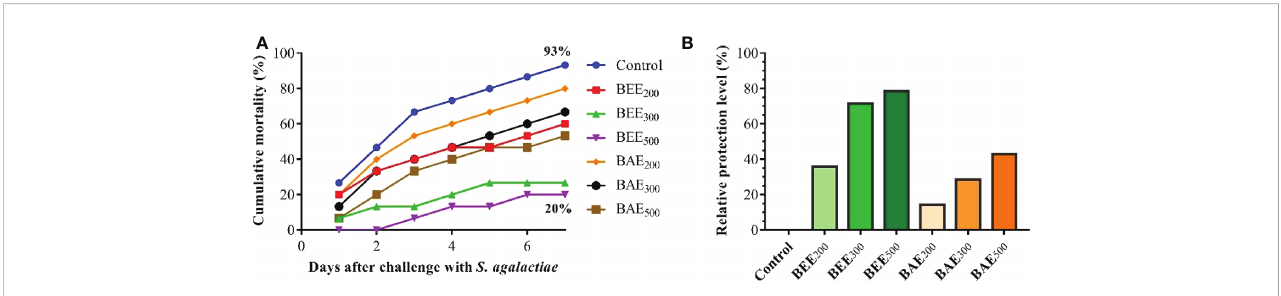
FIGURE 4 Cumulative mortality curve (A) and relative protection level (B) of Nile tilapia, Oreochromis niloticus , fed different dietary supplementation of basil ethanol (BEE) and aqueous extracts (BAE) and challenged with S. agalactiae